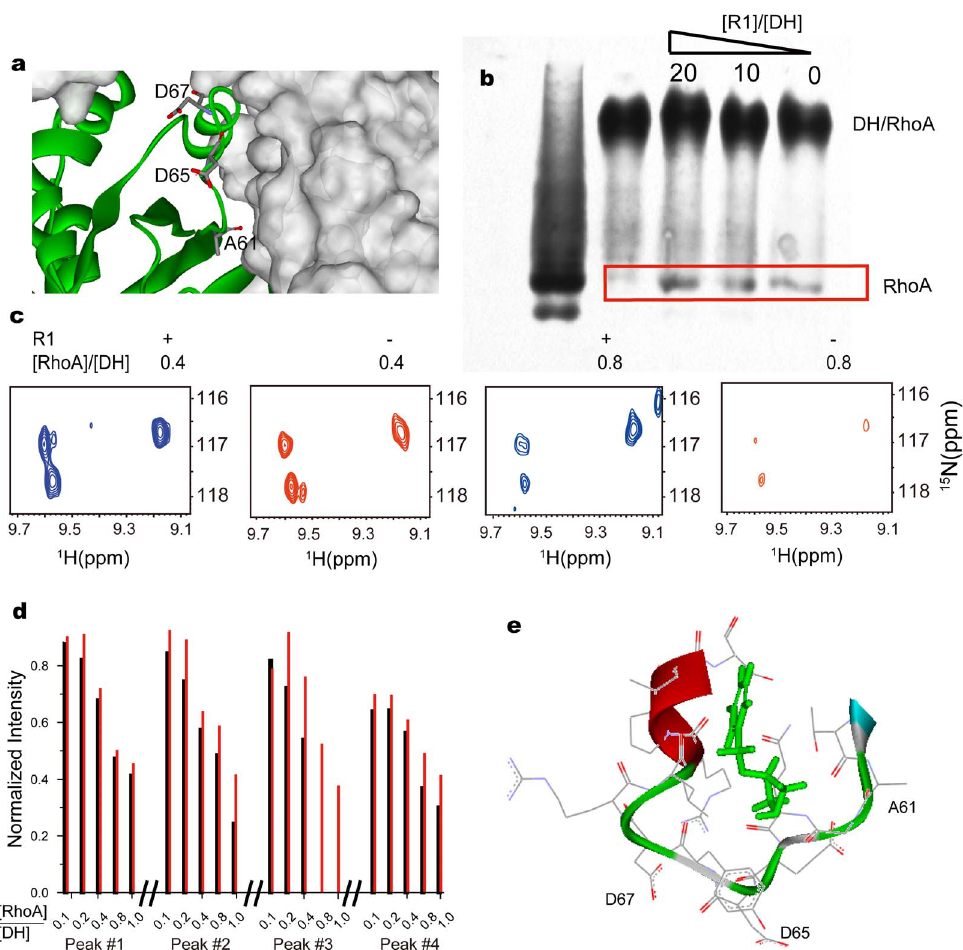
Figure 5. Compound R1 blocks the formation of DH/RhoA complex. a) Perturbed residues (stick representation and labeled) mapped to the DH (grey surface) and RhoA (ribbon) complex. b) The native gel electrophoresis running at pH 8.3 of RhoA alone (first lane) and DH/RhoA complex at the concentrations of 37.5 and 30 m M, respectively (second to fifth lane). The compound R1 was added at the denoted molar ratio to DH for the rightmost three lanes with equal amount of DMSO added, where red box highlighted the band for RhoA monomer. c) The 0.2 mM 15 N DH were first incubated with either 2 mM compound R1 or DMSO, and then subjected to the titration of non-labeled RhoA. Typical trosy HSQC spectra for these two samples ( + / 2 denotes the presence/absence of R1, respectively) were depicted at the RhoA/DH molar ratio of 0.4:1 and 0.8:1 as denoted, using the same display setting. For clarity, the spectra in the presence/absence of R1 were plotted in blue and red, respectively. d) Correlation between peak intensities of 15 N DH and RhoA/DH molar ratio, in the presence of DMSO (black lines) and compound R1 (red lines), respectively. Peaks 1–4 (numbered in Figure S5g) were separated by double lines. The intensities were normalized over those corresponding peaks in the absence of RhoA for each sample. Peaks with intensity less than 3 fold noise level were ignored. e) Simulated RhoA/R1 interactions using the CDOCKER scheme, where the binding site was defined as a sphere to accommodate all perturbed residues.